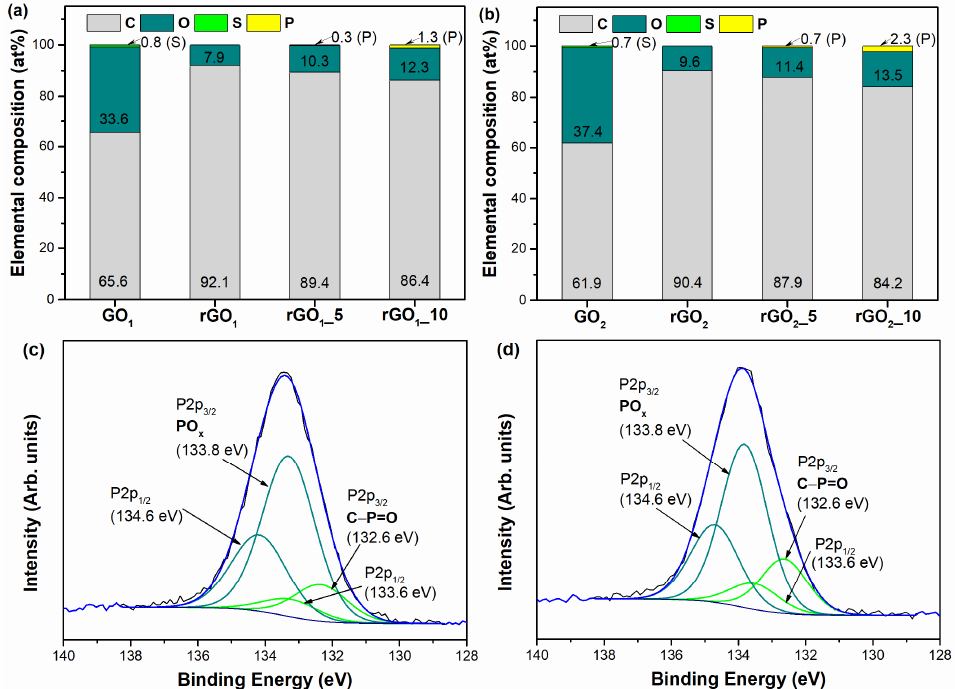
Figure 1. Elemental composition of GO 1 and thermally reduced samples derived from GO 1 ( a ), GO 2 and thermally reduced samples derived from GO 2 ( b ) based on EDX results. The P2p XPS spectra of rGO 1 _10 ( c ) and rGO 2 _10 ( d ) samples.